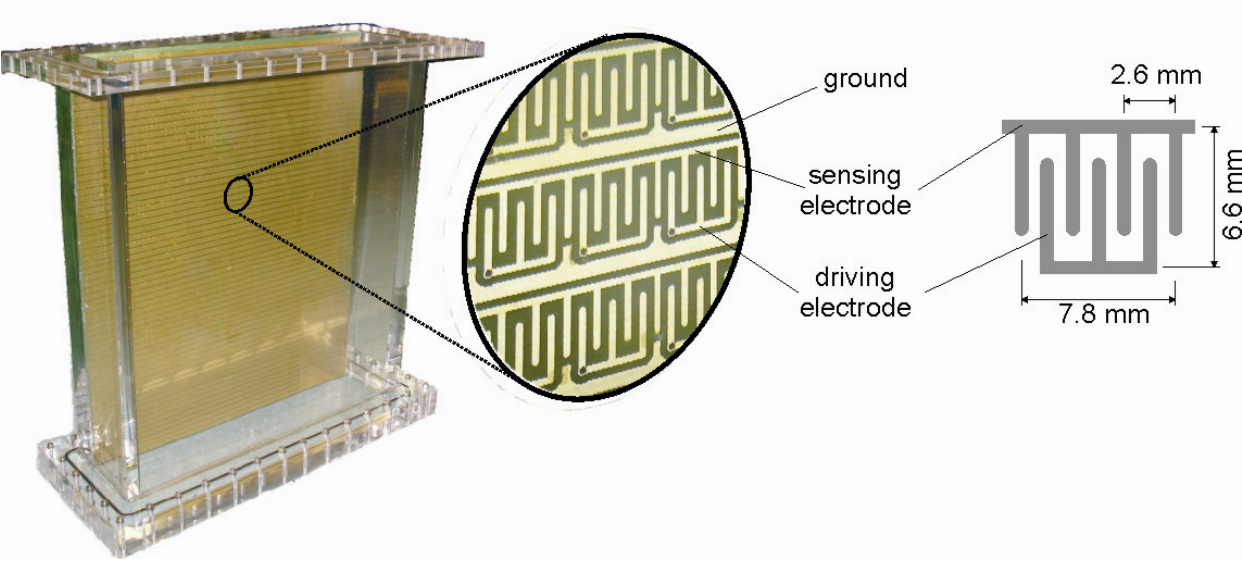
Figure 1 . Printed circuit board surface sensor containing 64 × 64 interdigital sensing structures fitted to an experimental flow channel. The size of each sensing structure is 5.8 mm × 6.6 mm and the size of the whole sensor is 620 mm × 500